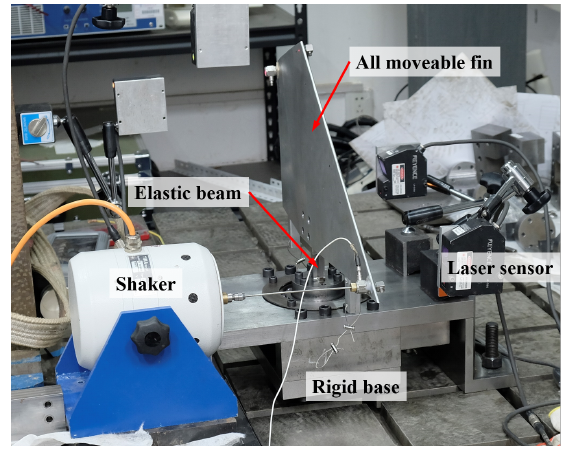
Figure 3. The supersonic flutter test platform.